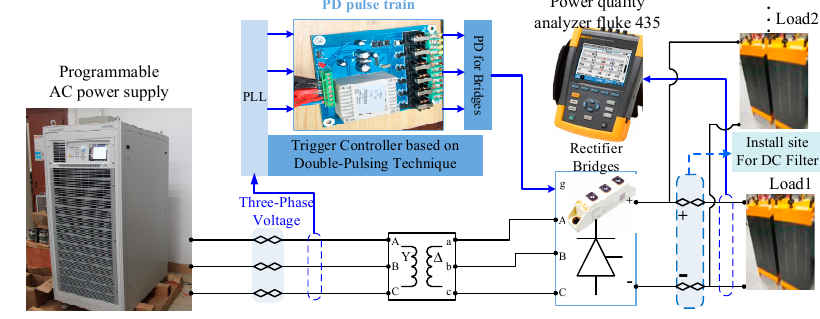
Figure 23. Experimental platform diagram.